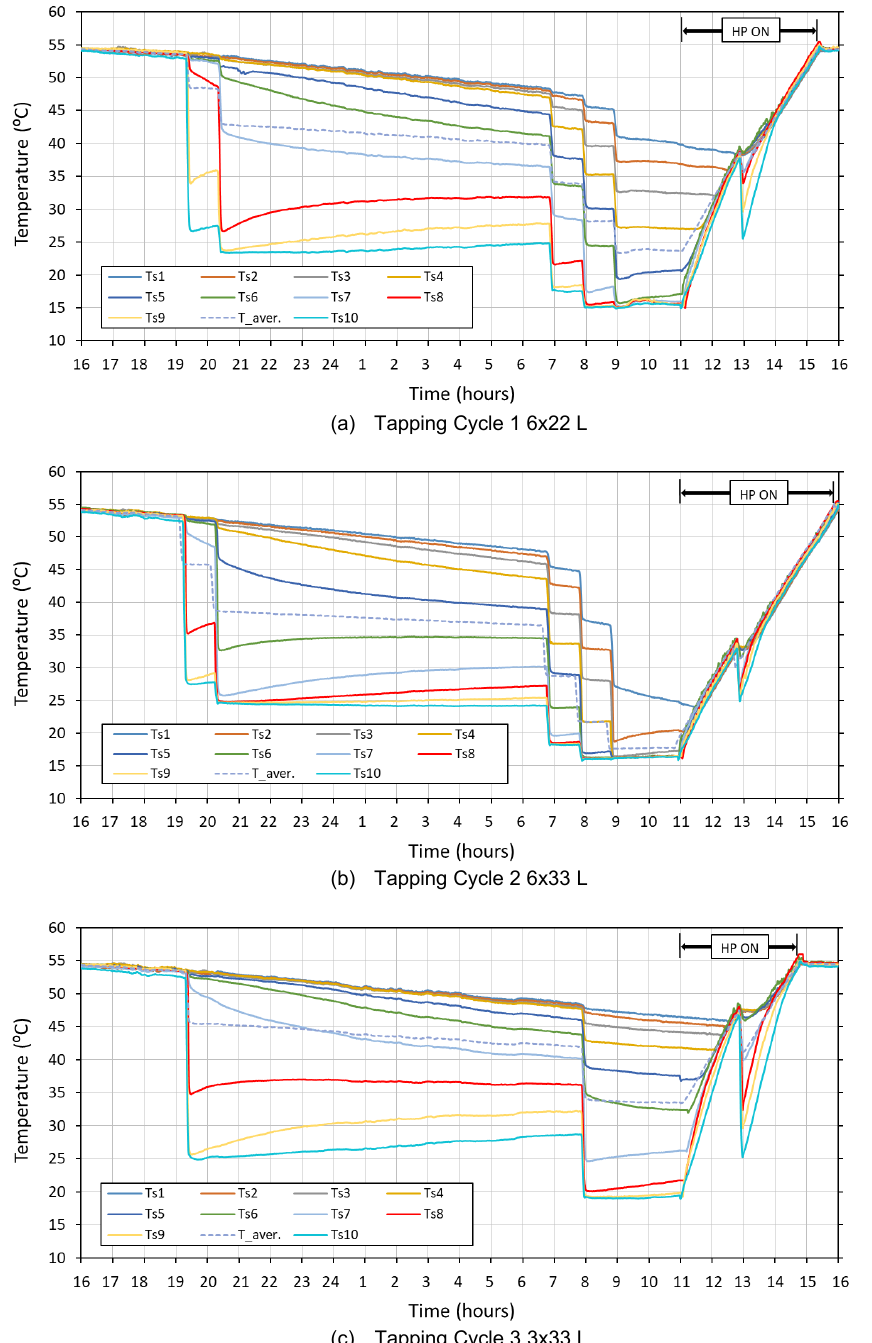
Figure 2. Water tank thermal stratification results. Experimental measurements of the tank wall temperatures along the vertical axis (top: T s ,1 , bottom: T s ,10